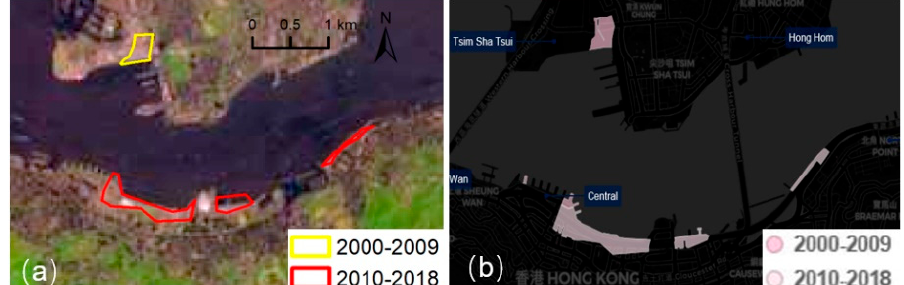
Figure 8. Comparisons between ( a ) our produced coastal reclamation result and ( b ) the Hong Kong reclamation map from official data. Figure 8a shows the selected four areas of coastal reclamation with the basemap of a Landsat image in 2018. The coastal reclamation area on the north coast of Victoria Harbor is Yau Ma Tei; the coastal reclamation area on the south coast of Victoria is Admiralty, Wan Chai, and North Point from west to east. In Figure 8a, the yellow and the red represent the coastal reclamation during 2000–2009 and 2010–2018. In Figure 8b, the pink and the light pink are the coastal reclamation projects from the Hong Kong Reclamation Map during 2000–2009 and